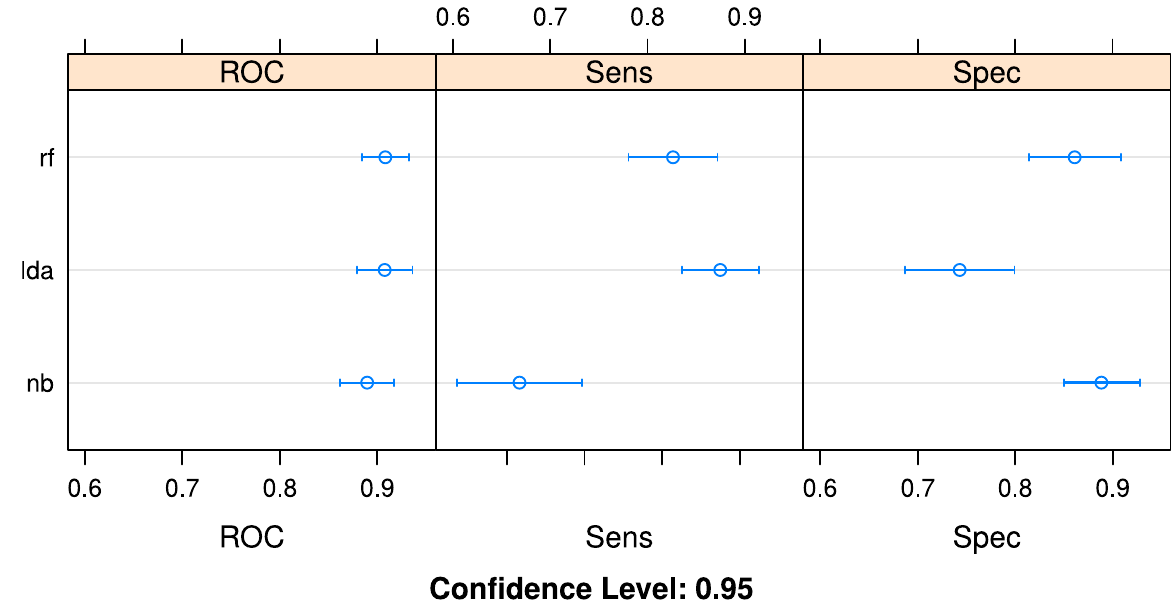
Figure 3. ROC, sensitivity and specificity for different classifiers.